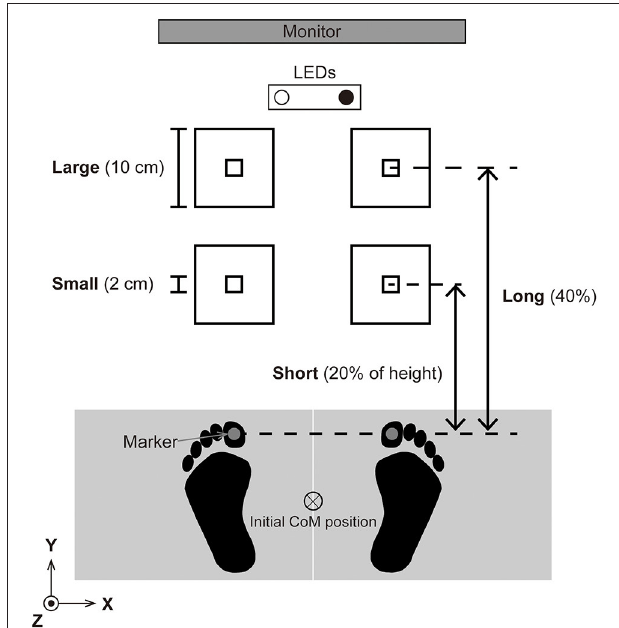
FIGURE 1 | Experimental setup. The participants were asked to step forward “as soon as, as fast as, and as accurate as possible” when one of the LEDs illuminated. The left and right LEDs illuminated at random, and whether the right or left LED was illuminated informed the participants which leg should be the leading leg. We tested two target sizes, small (square 2cm on a side) and large (10cm), and two target distance conditions, short (20% of each participant’s height) and long (40% of each participant’s height). The participants repeated 40 steps for each condition (total 160 trials). The position of the center of pressure (CoP) was visually feedbacked on a monitor in real time so that the participants were able to set the CoP in the middle of the base of